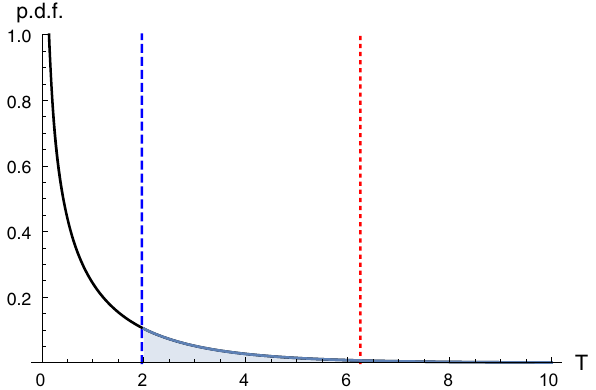
Fig. 1 Illustrationinthesimplecasewhere X ispredictedas x (μ) = μ . Under the hypothesis μ t = μ , and having measured X = 0 ± 1, one can determine the associated p value p ( 0 ; μ) by examining the distribution of the quadratic test statistic T ( X ; μ) = ( X − μ) 2 assuming X is distributedasaGaussianrandomvariablewithcentralvalue0andwidth 1. The blue dashed line corresponds to the value of T associated with the hypothesis μ = − 1 . 4, with a p value obtained by considering the gray area . The red dotted line corresponds to the hypothesis μ = 2 .